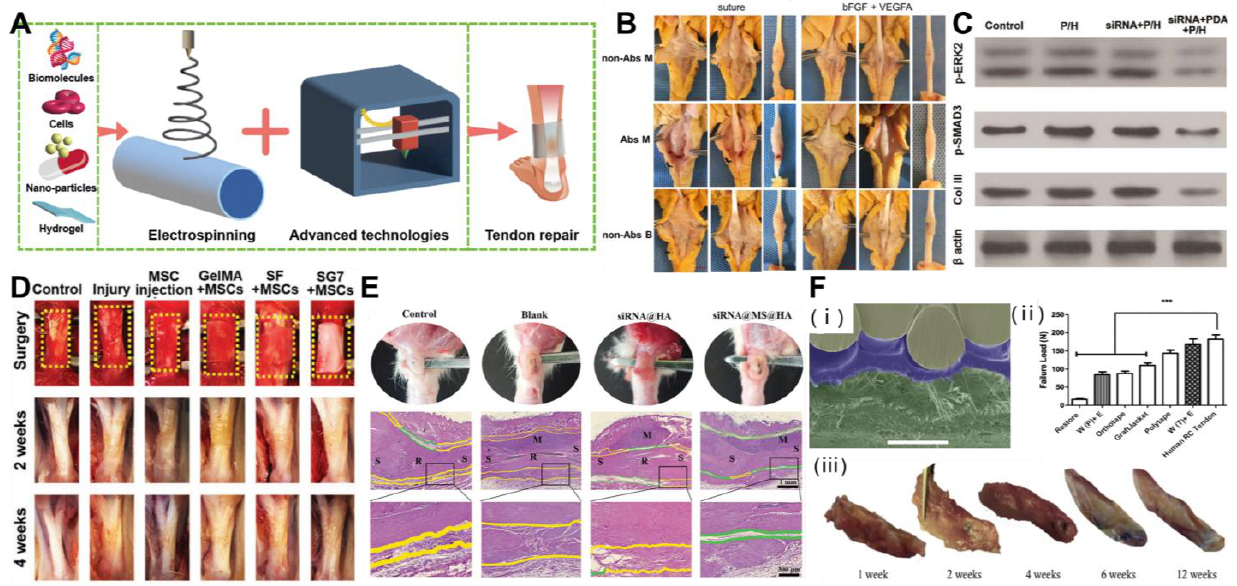
Figure 3. Treatment of tendon injury with composite electrospinning technology. ( A ) Scheme of bioactive materials and/or advanced technology combined with electrospinning for tendon repair.